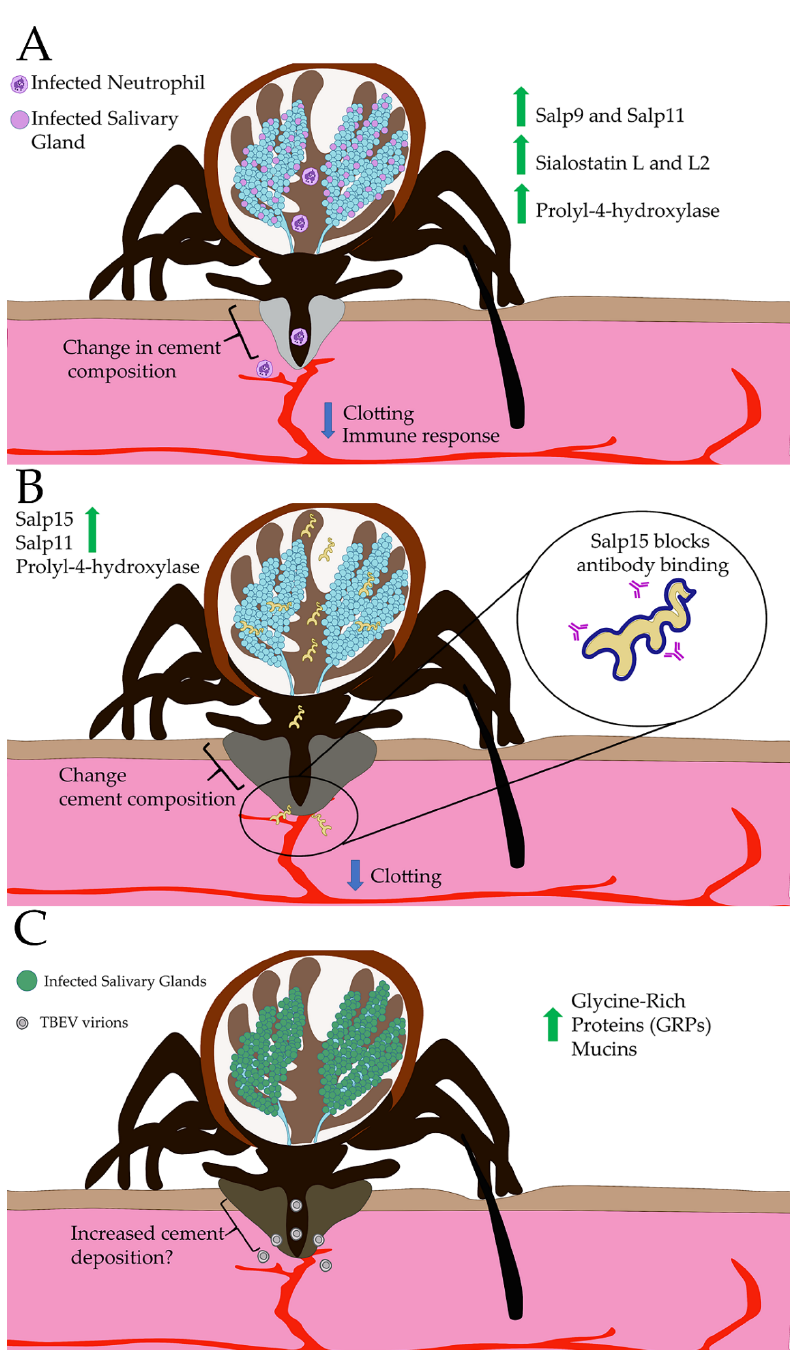
Figure 2. Tick-borne pathogens manipulate the expression of tick salivary effectors to enhance their transmission. ( A ) A . phagocytophilum infected neutrophils are taken up by the tick during its bloodmeal. Once in the tick, A . phagocytophilum infects salivary glands as early as 24 to 48 h. In the salivary